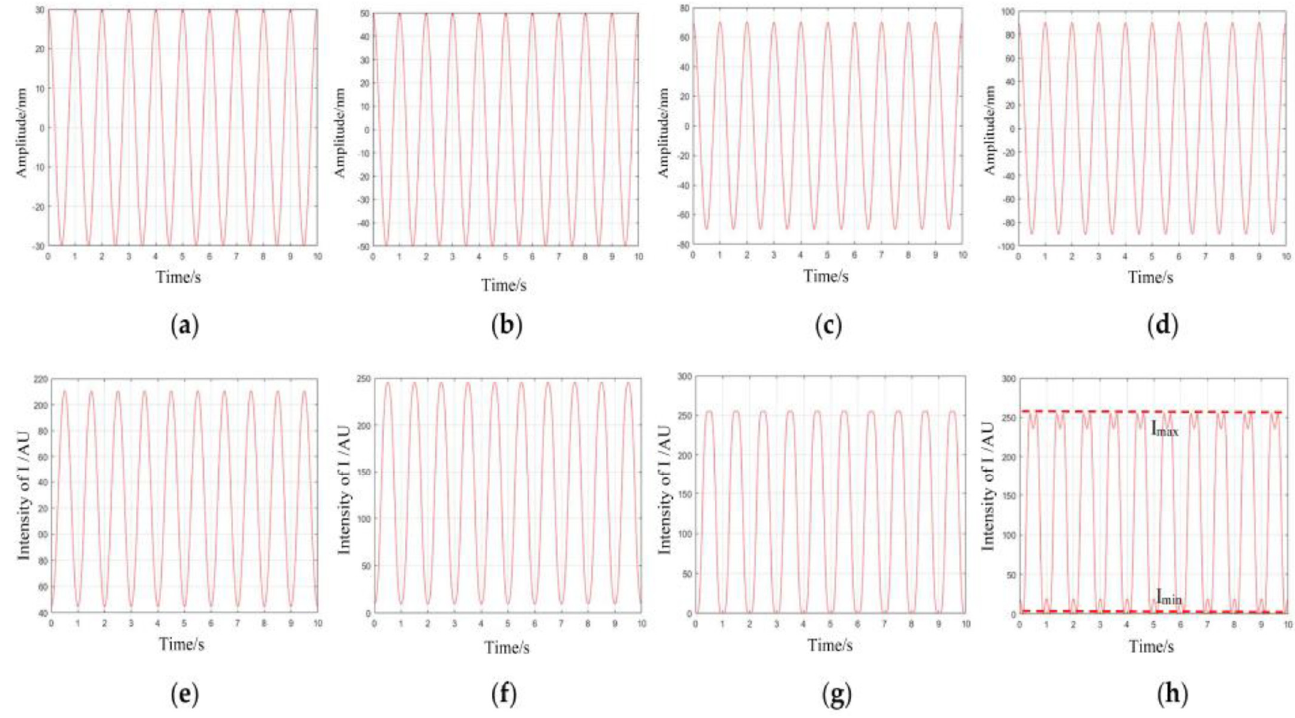
Figure 2. ( a – d ) are the real-time position of the measured object when the amplitude A = 30 nm, 50 nm, 70 nm, 90 nm; ( e – h ) are the corresponding interference light intensity curves.